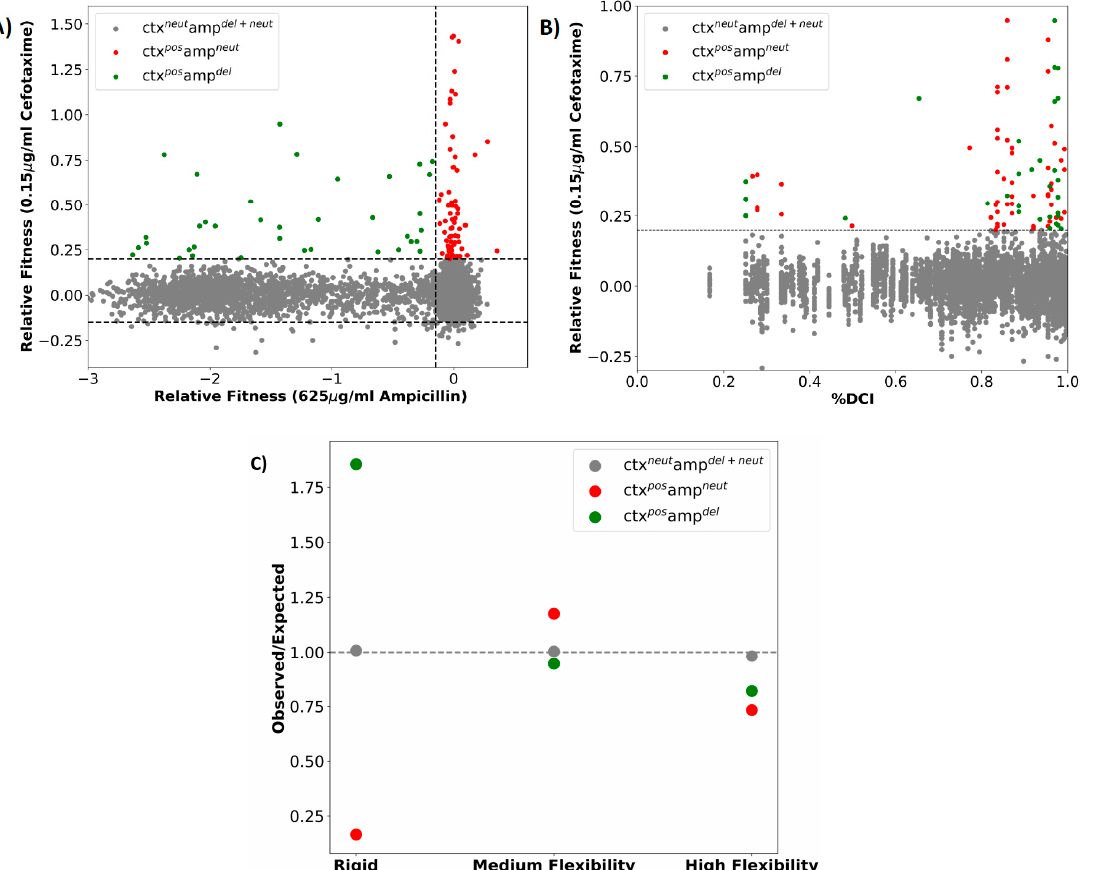
Figure 5. ( A ) Relative fitness values for all mutations under ampicillin (625 mg/mL (x-axis) versus CTX selection (0.15 mg/mL; y-axis) showed that most mutations conferring significant CTX resistance were mostly neutral (red), but some were deleterious (green) in ampicillin resistance, while the color grey shows the variants with no effect on cefotaxime resistance. ( B ) Change in the relative fitness of the organism upon various mutations as a function of their %DCI couplings with the active site. We observed that a majority of the mutations with positive fitness in CTX were highly coupled to the active region (%DCI > 0.7). ( C ) Observed to expected ratio of TEM1 variants based on their flexibility category.